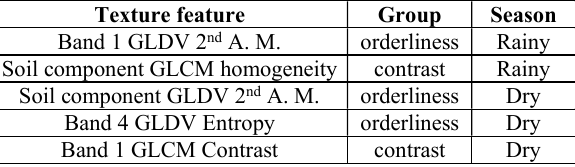
Table 6: Selected texture features for experiment 4 considering the dry and rainy seasons.